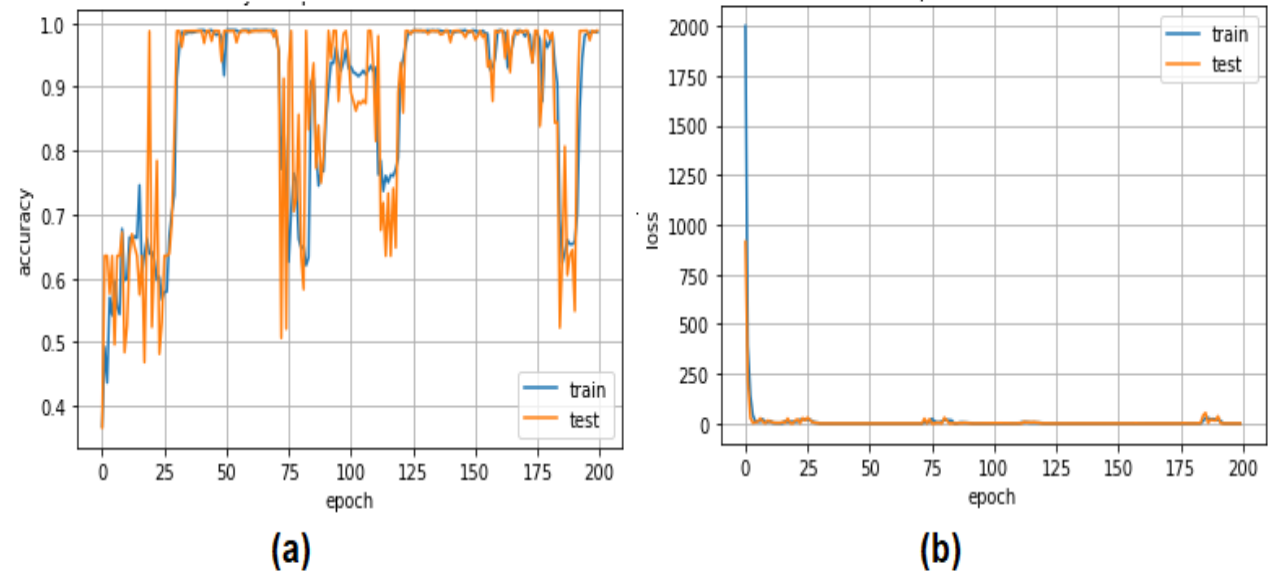
Figure 8. Performance and loss accuracy of the CNN-LSTM model using the binary dataset. ( a ) model accuracy ( b ) model